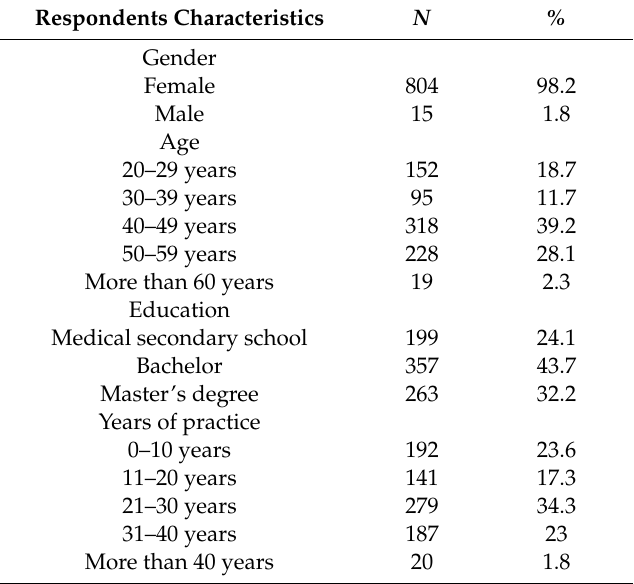
Table 1. Survey participants’ demographic data.